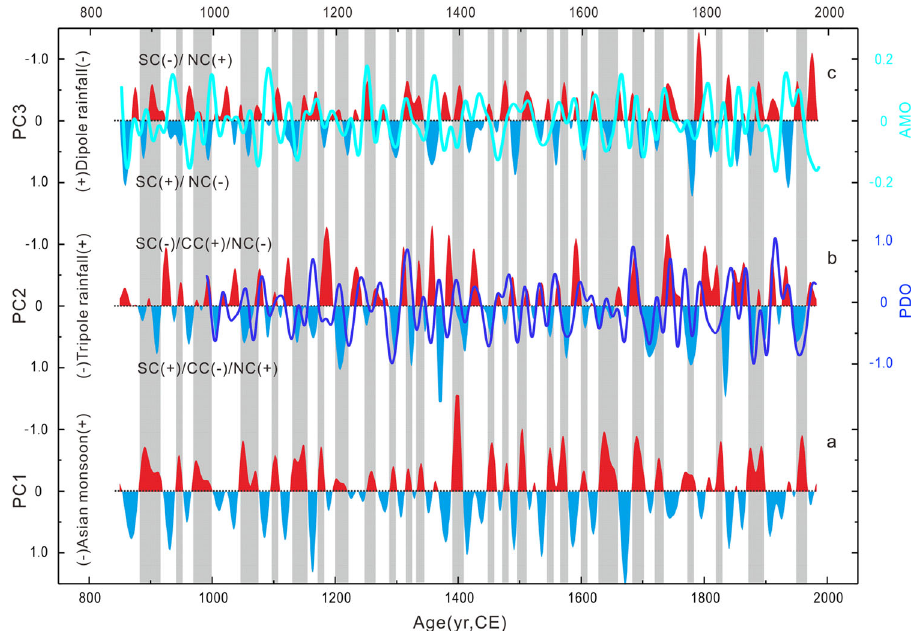
Fig. 6 Interactions between the precipitation distribution pattern in East China and the monsoon with PDO and AMO. All the data are processed by bandpass fi ltering. a The monsoon variation indicated by PC1. b The tripole rainfall pattern revealed by PC2 and PDO (in the dark blue). The relationships between them are reversed in 1400 CE. Before 1400 CE, the variations of PC2 and PDO are in-phase, after that, they are anti-phase. c The dipole rainfall pattern suggested by PC3 and AMO (in light blue). During 880 – 1130, 1310 – 1500, and 1780 – 1980 CE, the variations of AMO and PC3 are generally in- phase, while during 1130 – 1310 and 1500 – 1780 CE, they are anti-phase. On multi-decadal scales, the unstable relationships of PC2-PDO and PC3-AMO suggest that it is the mutual interactions among the monsoon, PDO, and AMO, rather than any induvial factor, that in fl uences the precipitation distribution pattern in East